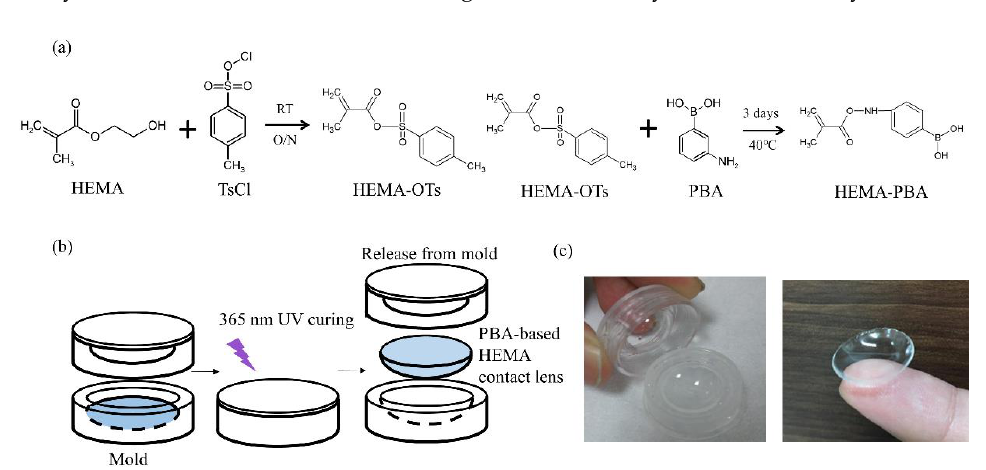
Figure 2. Synthetic process and fabrication of the PBA-based HEMA contact lens. ( a ) To obtain a contact lens sensitive to the glucose level. The synthesis process of the PBA-based HEMA contact lens including HEMA-OTs, fabrication of the contact lenses, and modification of 3-phenylboronic acid on HEMA-PBA. ( b ) Schematic of the PBA-based contact lens molding process. HEMA-PBA mixture was added to each mold, and cured with 365 nm UV. Then, the PBA-based HEMA contact lenses were formed in the mold, then demolded. ( c ) The photograph of the PBA-based HEMA contact lens was fabricated using ( b ). fabricated using ( b